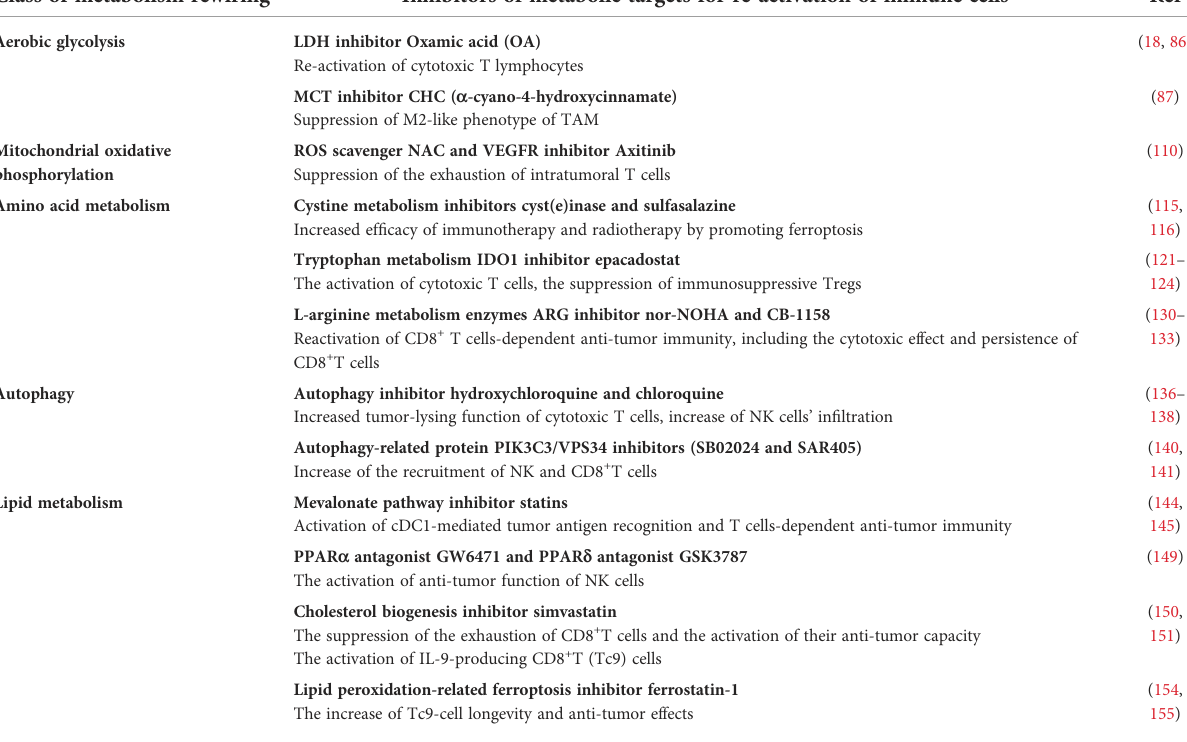
TABLE 2 List of inhibitors of metabolic targets for re-activation of immune cells. Class of metabolism rewiring Inhibitors of metabolic targets for re-activation of immune cells Ref Aerobic glycolysis